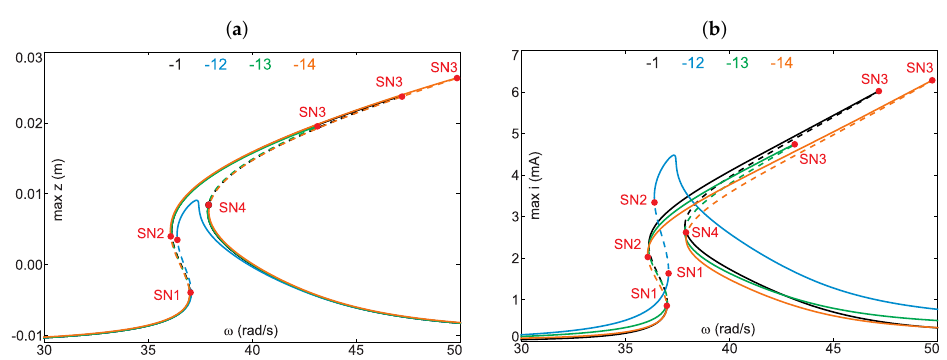
Figure 8. Comparison of frequency responses of the maximal magnet displacement ( a ) and the maximal induced current ( b ) when the active coil module is changed. The analysis was performed near the main resonance. The SN point denotes saddle-node bifurcation.